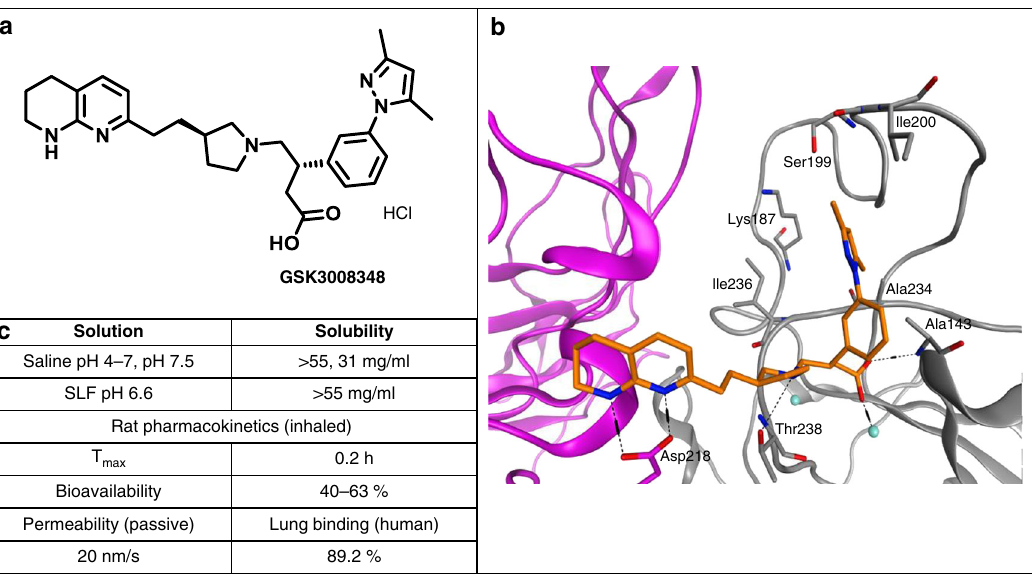
Fig. 1 Structure, solubility, and pharmacokinetic properties of GSK3008348. a The chemical structure of GSK3008348 with full chemical name: ( S )-3- (3-(3,5-dimethyl-1 H -pyrazol-1-yl)phenyl)-4-( R )-3-(2-(5,6,7,8-tetrahydro-1,8-naphthyridin-2-yl)ethyl)pyrrolidin-1-yl)butanoic acid). b Docked GSK3008348 (orange) in a homology model of α v β 6 based on α v β 3 X-ray (1L5G) composed of α -subunit (magenta) and β -subunit (gray). c Solubility